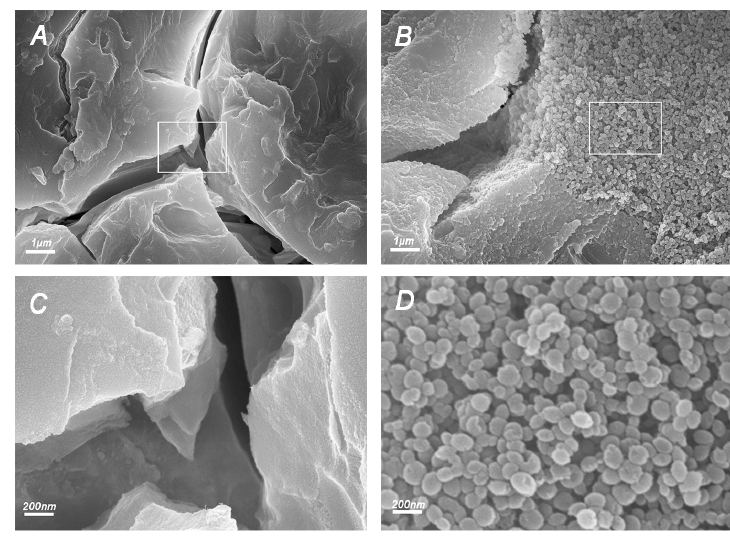
Figure 6. FESEM images of fracture surfaces from ( A ) control; and ( B ) 10% CHX@pMSN groups. ( C , D ) are magnified pictures of rectangles in ( A , B ) respectively.